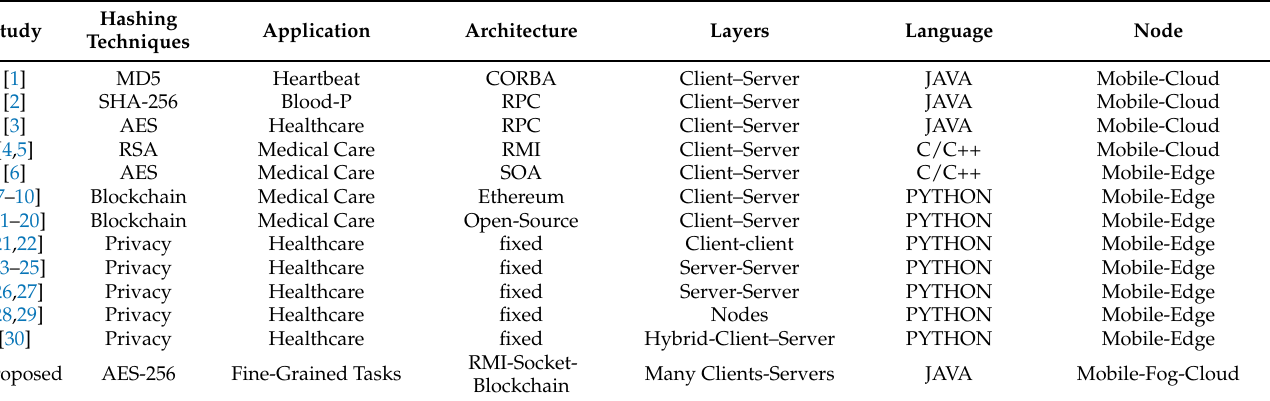
Table 1. Existing Healthcare Client Server Frameworks Based on RMI, RPC, and Socket.